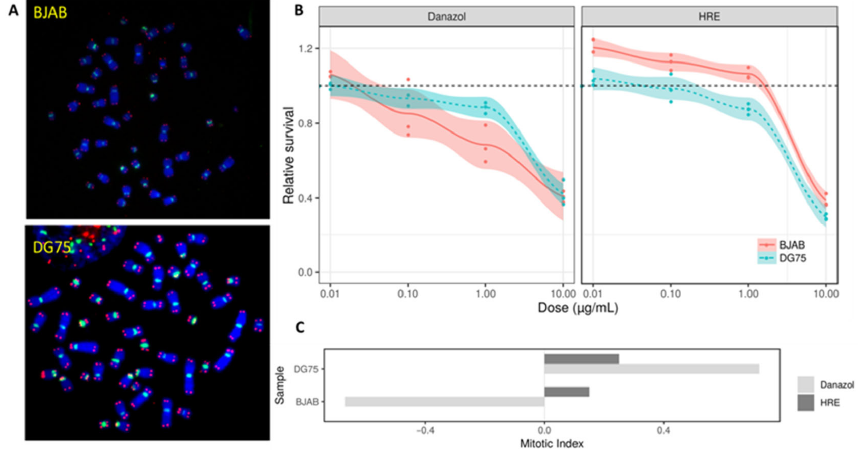
Figure 2. Toxicity of hydroethanolic root extract (HRE) and danazol. BJAB and DG-75 cells were incubated with increasing doses of the HRE or danazol for 3 days. ( A ) Metaphases from BJAB and DG75 cell lines stained with a Cy3 telomere probe (red) and FITC centromere probe (green) showing drastically short telomeres in BJAB cells. ( B ) Cell viability determined by manual cell counting after staining with trypan blue. Relative survival was calculated after in vitro exposure to the HRE or danazol. The data are representative of three independent experiments and expressed as the mean ratio ± standard error of the mean. The experiments were performed in triplicate. ( C ) Mitotic index variation after exposure to HRE and danazol for 3 days following a single dose of 1 µ g / mL. Two slides were used for each condition.